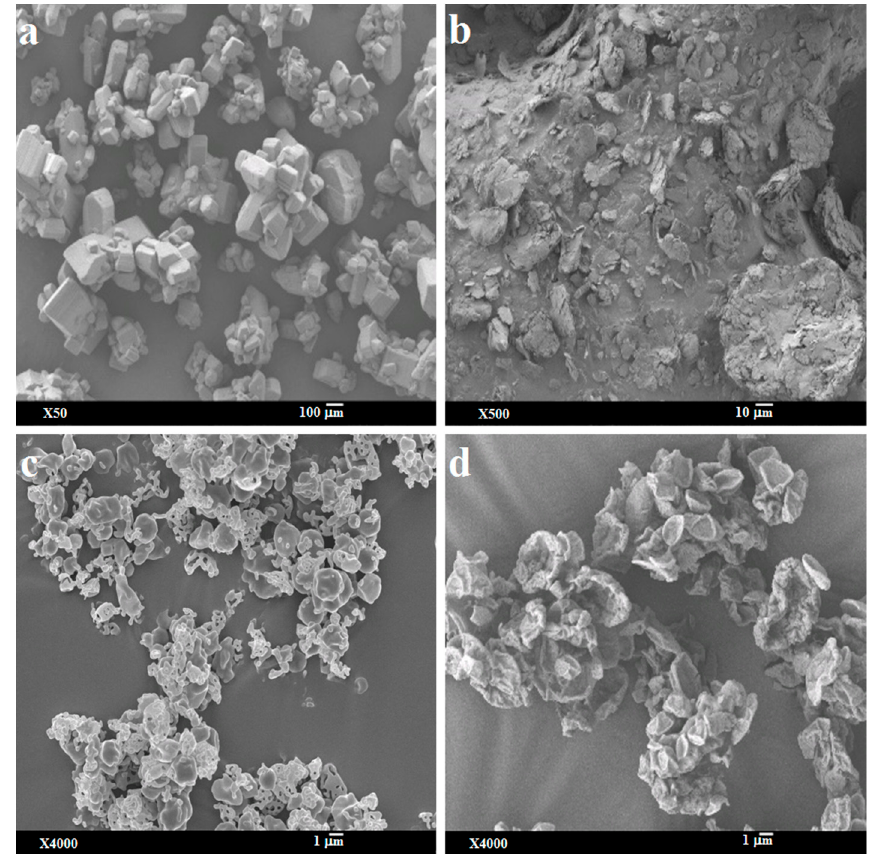
Figure 1. Representative scanning electron micrographs of: ( a ) supplied bedaquiline; ( b ) supplied l -leucine; ( c ) spray-dried bedaquiline-only and ( d ) spray-dried bedaquiline with 20% l